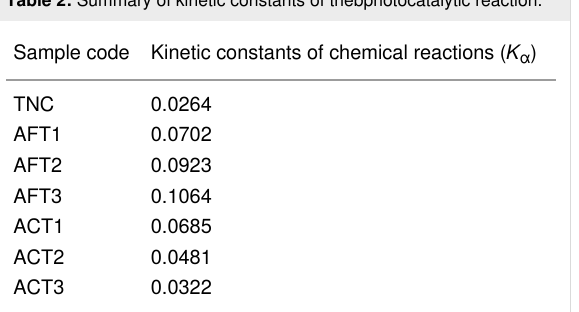
Table 2: Summary of kinetic constants of thebphotocatalytic